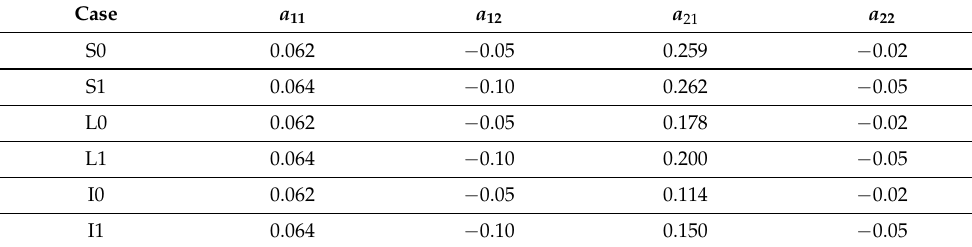
Table 4. Dynamical matrix coefficients used in the different case studies. The a 21 parameter is determined by the flight type. For each of these, two values of the cancellation parameter a 12 are considered.